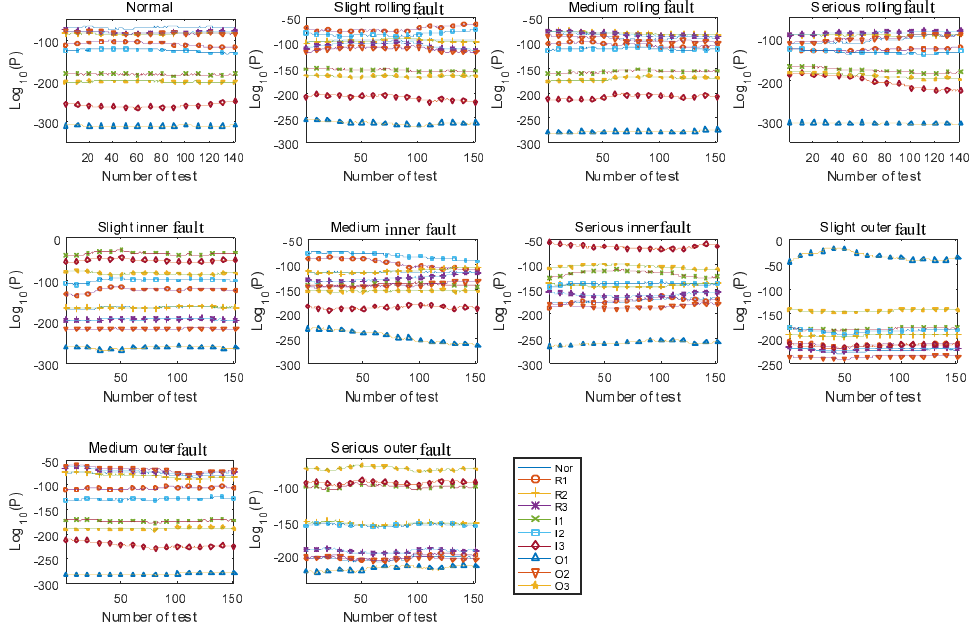
Fig. 6 Identification results of various fault states of bearing for every 100 observation samples.